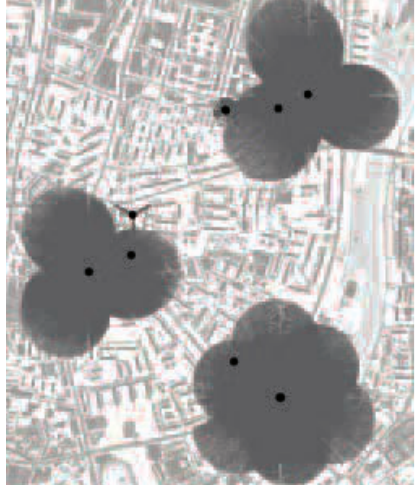
Fig. 4. Arrangement of antennas and ray propagation in experimental locality